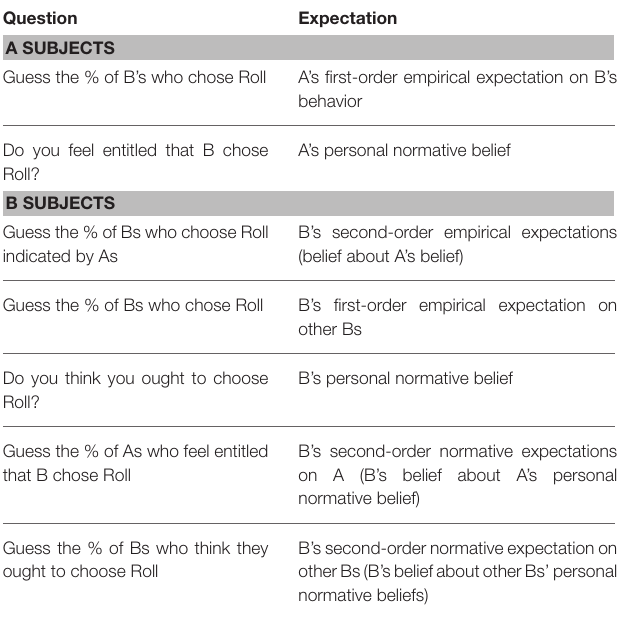
TABLE 1 | Questions used to elicit different kinds of